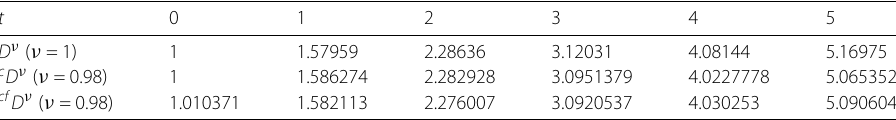
Table 2 Results of three types of derivative: Ordinary derivative D ν , Caputo fractional derivative c D ν , and Caputo–Fabrizio fractional derivative cf D ν for I ( t